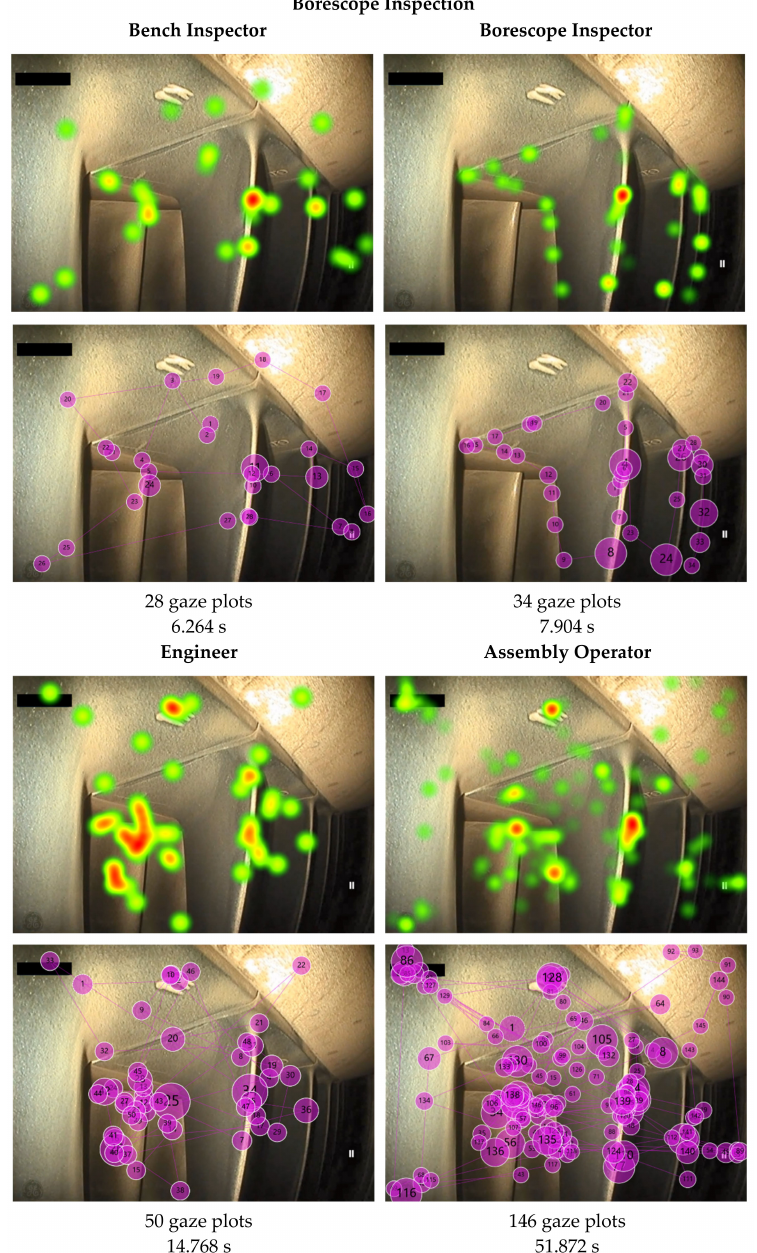
Figure 17. Eye tracking results by expertise for the same blade shown in Figure 16 but now as borescope